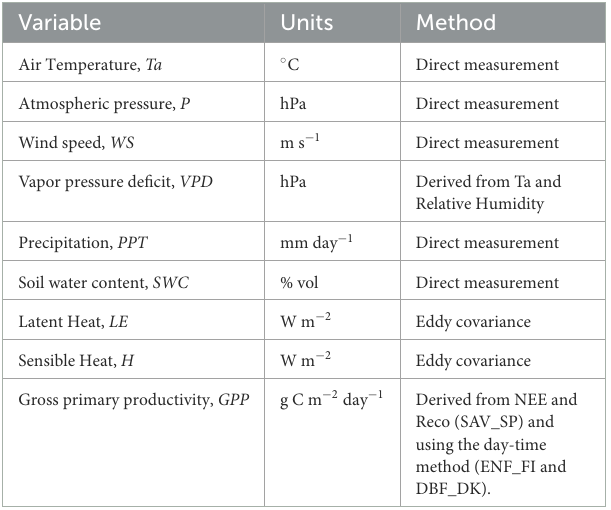
TABLE 2 Variables obtained from the flux tower